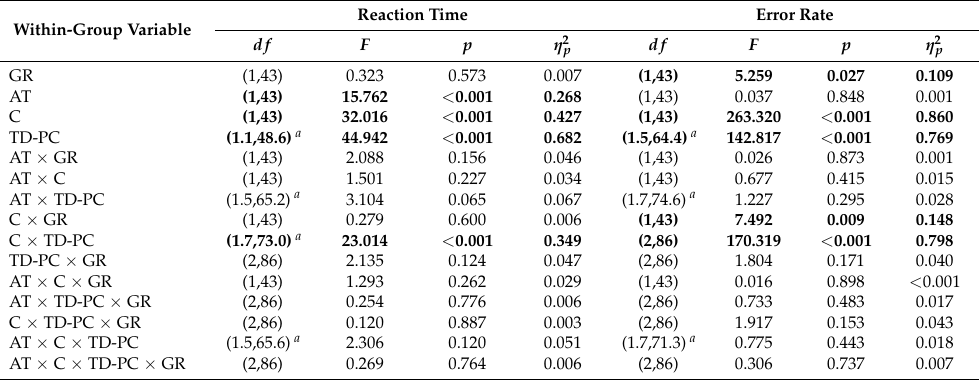
Table 1. Repeated-measures ANOVA results for reaction time and error rate. Reaction Within-Group Variable